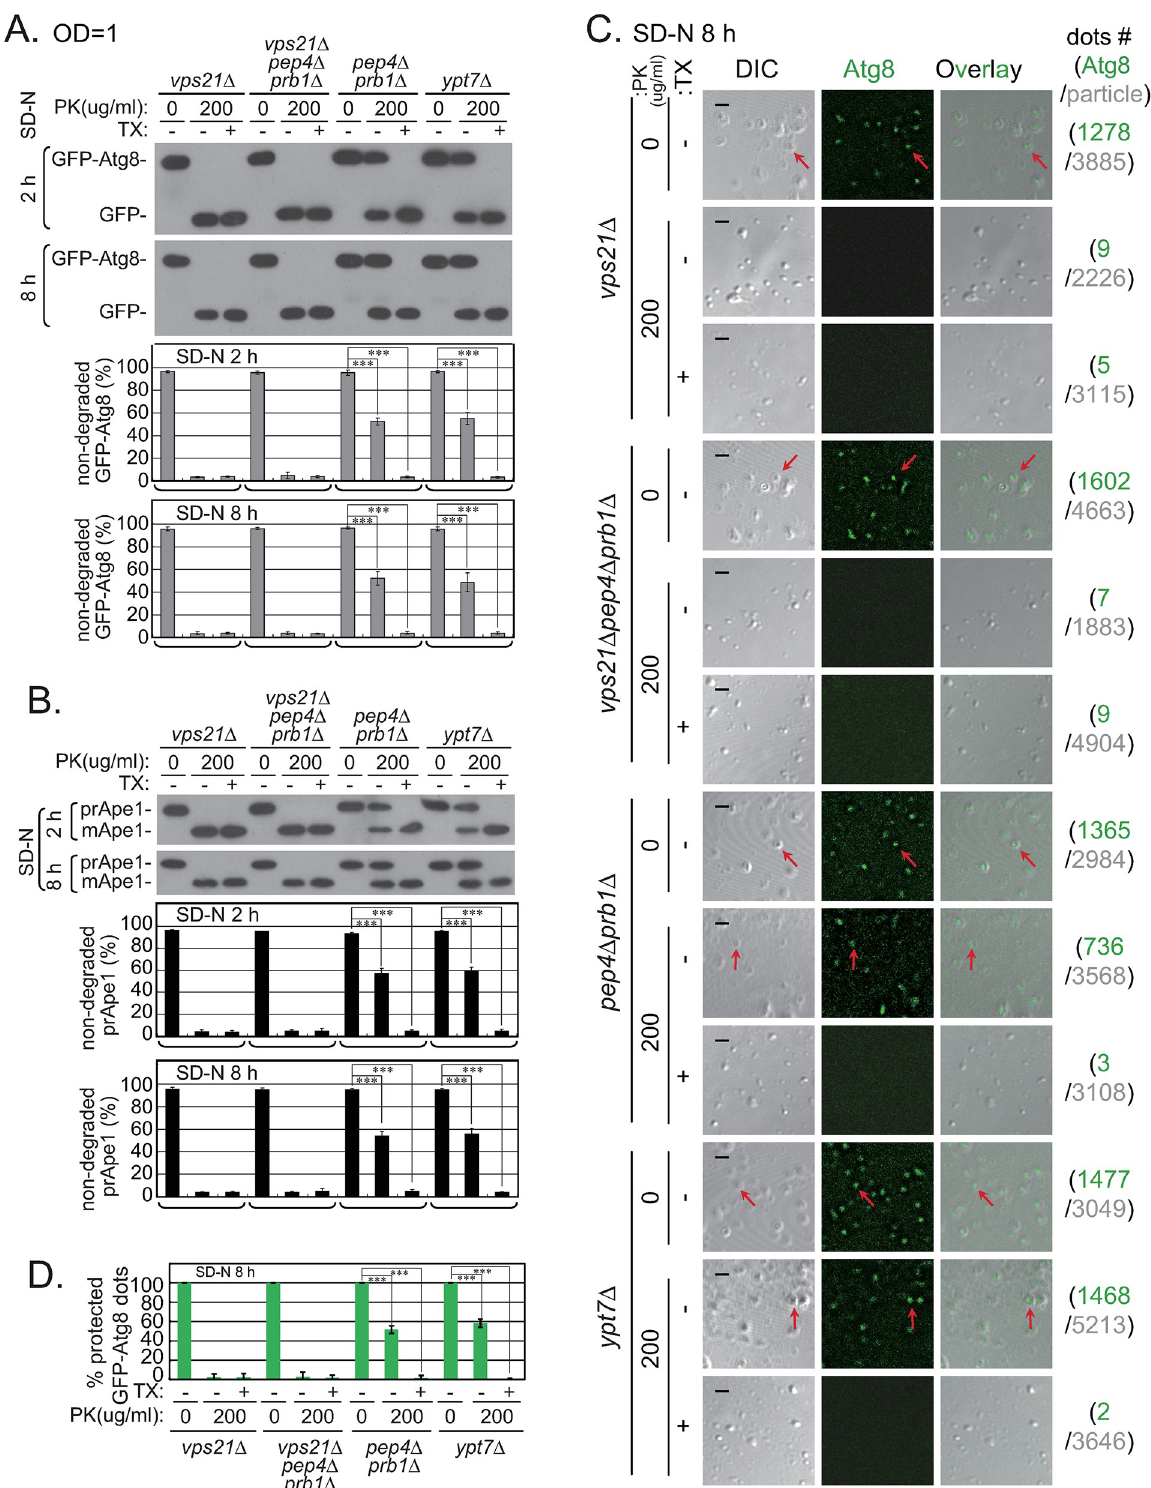
Fig 6. AP-related membrane structures that entered vacuoles of vps21 Δ cells after prolonged nitrogen starvation were sensitive to protease K (PK) digestion. Cells were grown as described in Fig 2A and subjected to a conventional protease K (PK)-protection assay as described [10,45] or a modified microscopy-based PK-protection assay [10,26]. The ypt7 Δ and pep4 Δ prb1 Δ cells served as controls for closed APs outside vacuoles